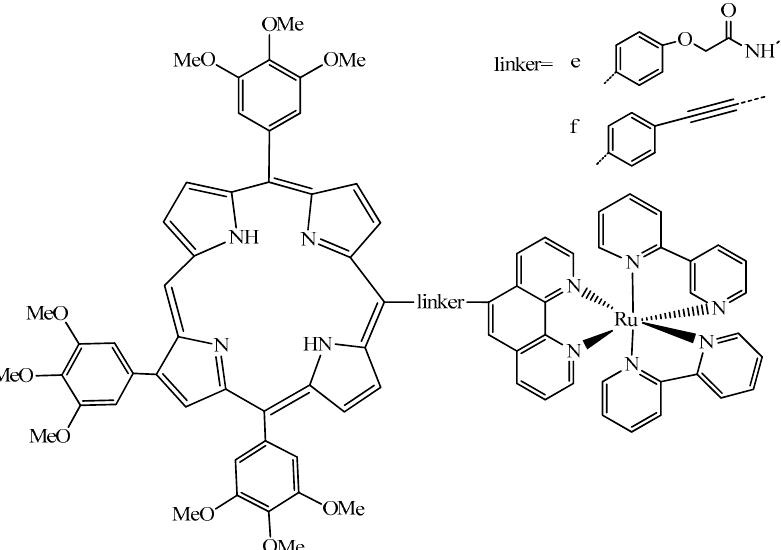
Figure 4. Chemical structure of [Ru(bipy) 2 (phen)] 2+ (phen = 1,10-phenanthroline, Me = methyl group) linked to a porphyrin moiety. Adapted from [48] with permission from the journal Chem. Sci , Copyright 2015.